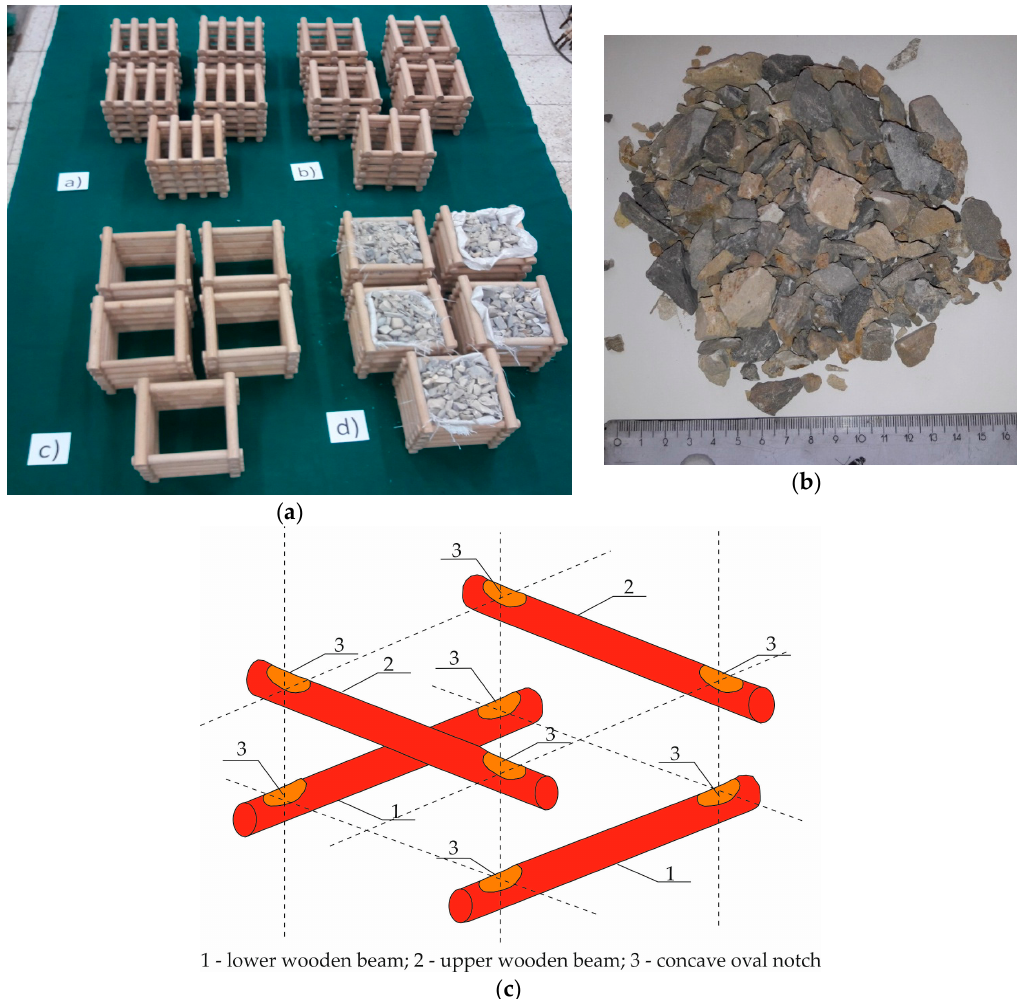
Figure 5. General view of mining cribs models: ( a ) Empty eight-point, six-point, four-point, and four-point filled by waste rocks; ( b ) Waste rocks; ( c ) Connection of wooden beams by means of concave round notches.